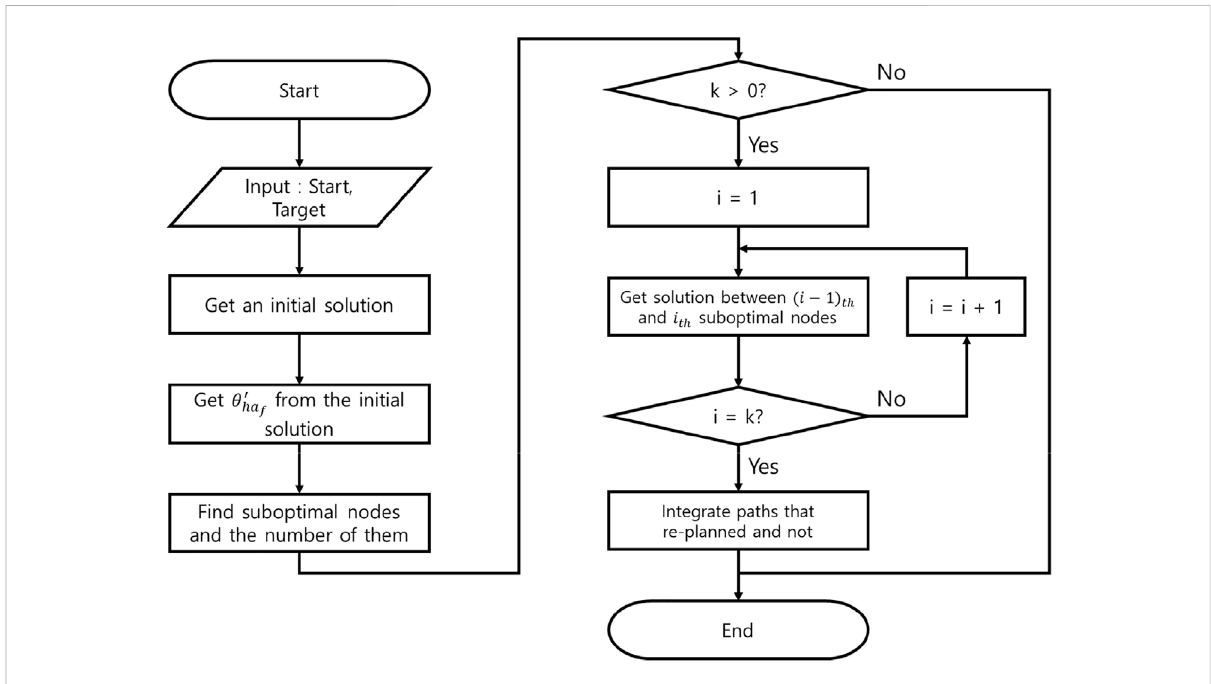
FIGURE 8 Flowchart of